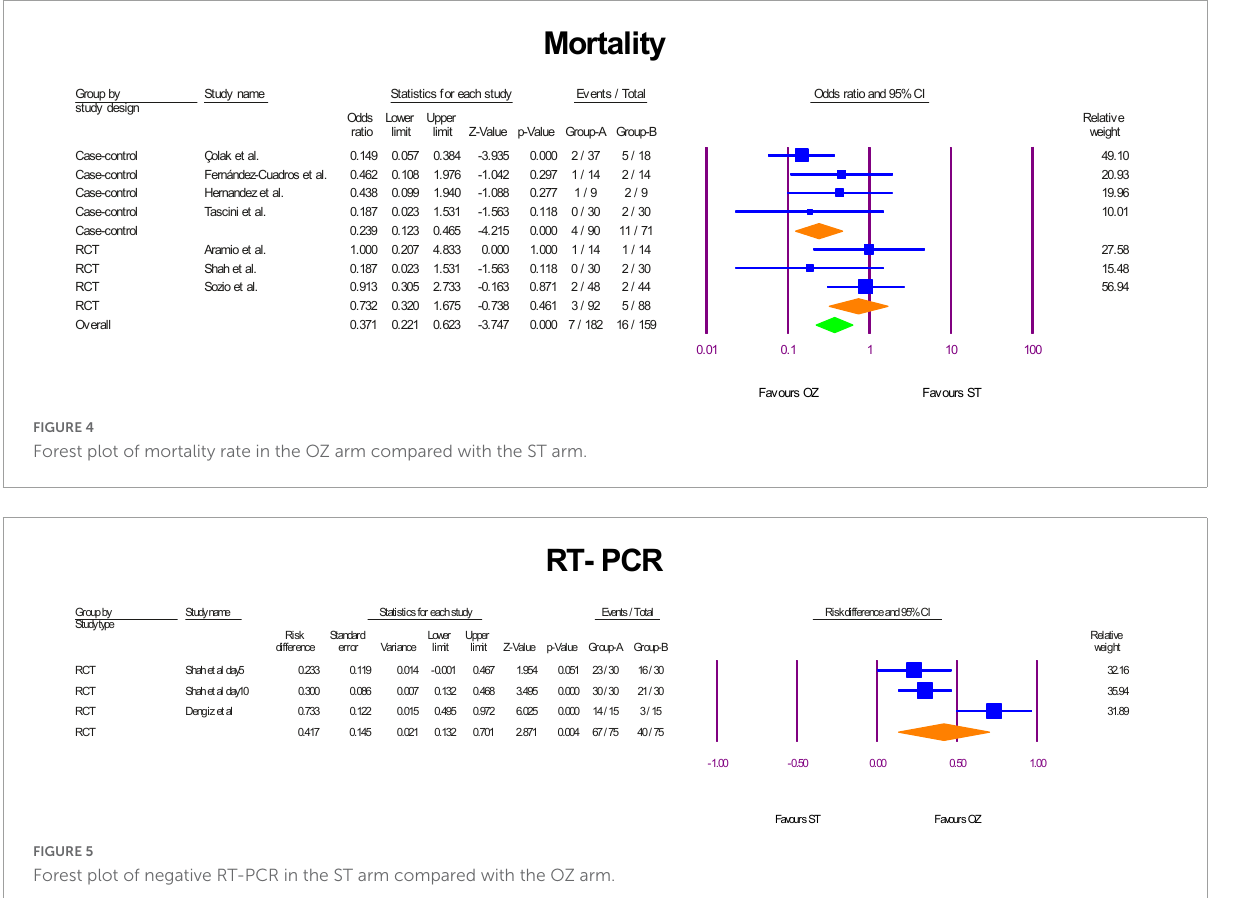
P = 0.007, I2 = 0, fixed-effect) ( Figure 7A ). Further, neither in the OZ (MD = 0.11 mg/dL, P = 0.150, I2 = 82.31, random-effects) nor in the ST (MD = 0.18 mg/dL, P = 0.398, I2 = 89.31, random-effects) groups, the interventions were not associated with total bilirubin levels changes ( Figure 7B